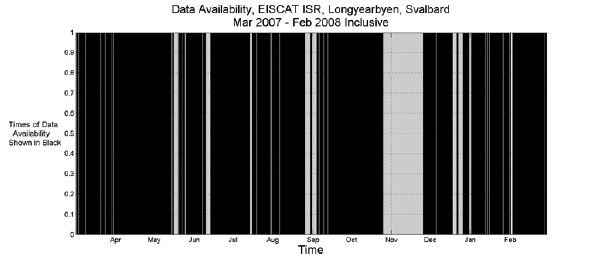
Fig. 3. ISR data availability for the study period.